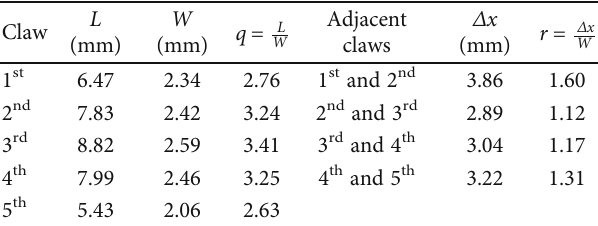
Table 2: Geometrical parameters and structural elements of the multiclaw